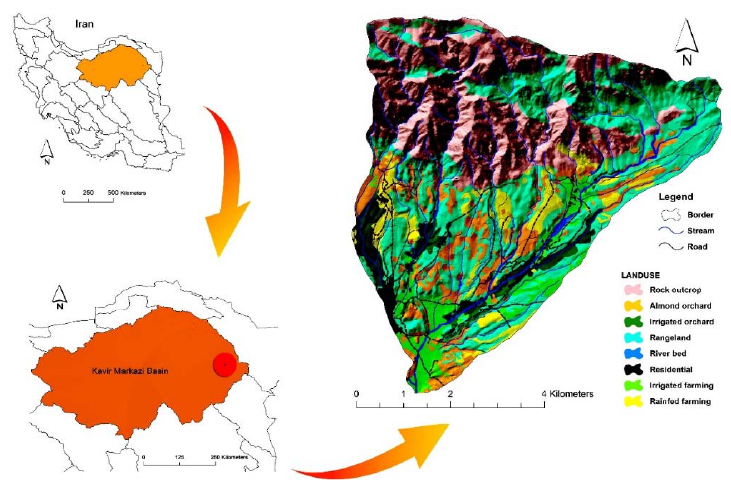
Fig. 1: Geographic location of study area, overlaid on land use map